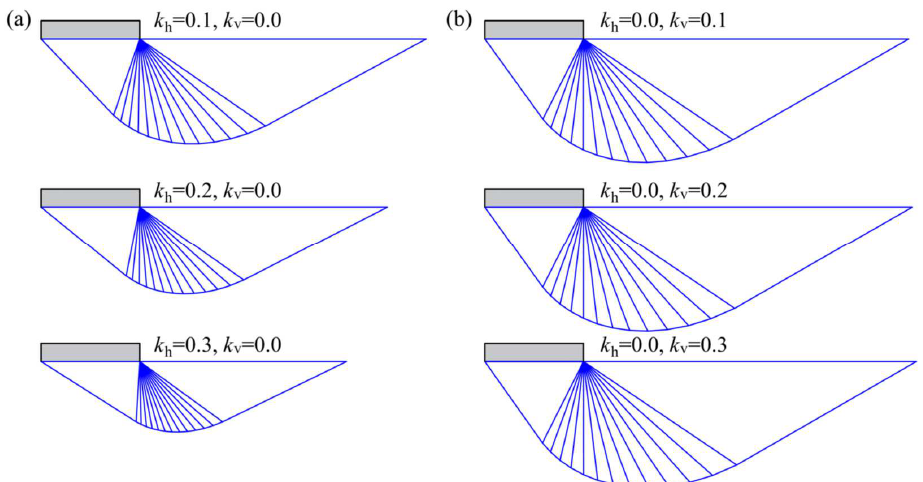
Figure 10. Critical failure surfaces for different p , c 0 , m , and σ t . ( a ) Effects of p. ( b ) Effects of c 0 . ( c ) Effects of m. ( d ) Effects of σ t .